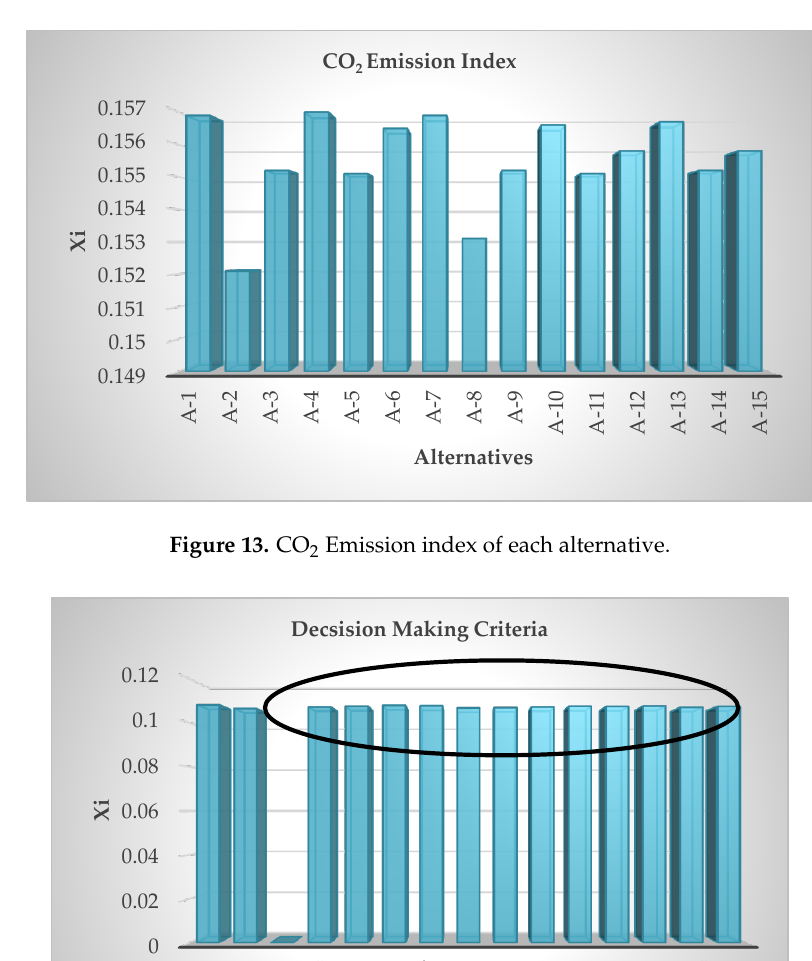
Figure 12. Electricity price index of each alternative.